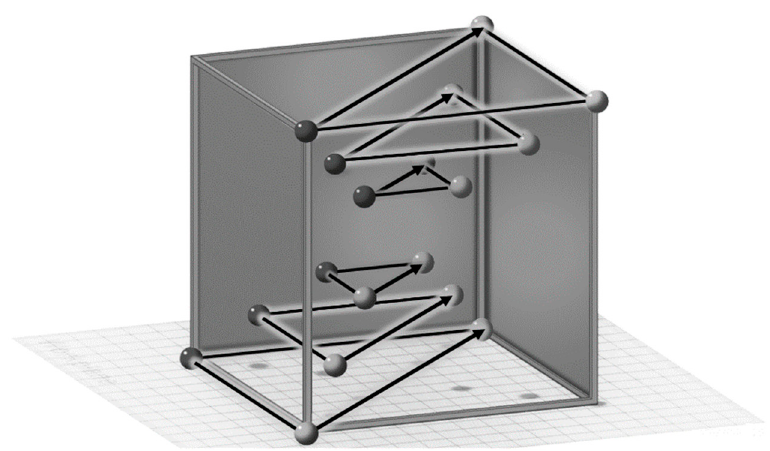
Figure 2. The basic rotational pattern in HRC3DS consists of six peaks, all with the same J value, that form two triangles. The size of each triangle pair grows with increasing J. The above cartoon shows three pairs of triangles (small, medium, and large) for J = 1, 2, and 3.